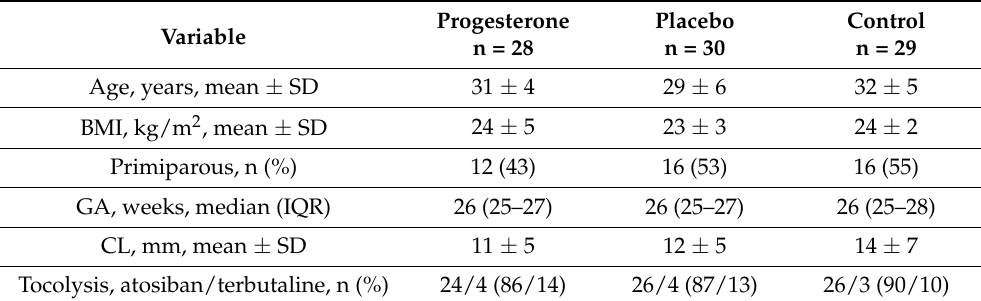
Table 1. Maternal